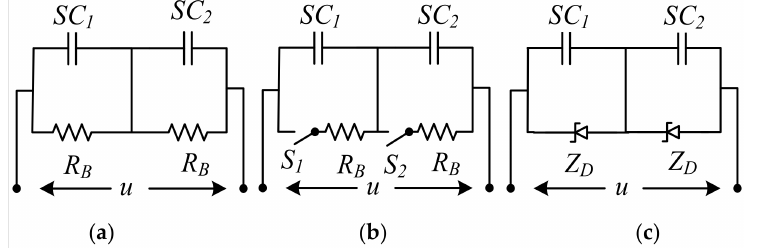
Figure 16. SC voltage balance ( a ) resistor, ( b ) switched resistor, ( c ) Zener diode